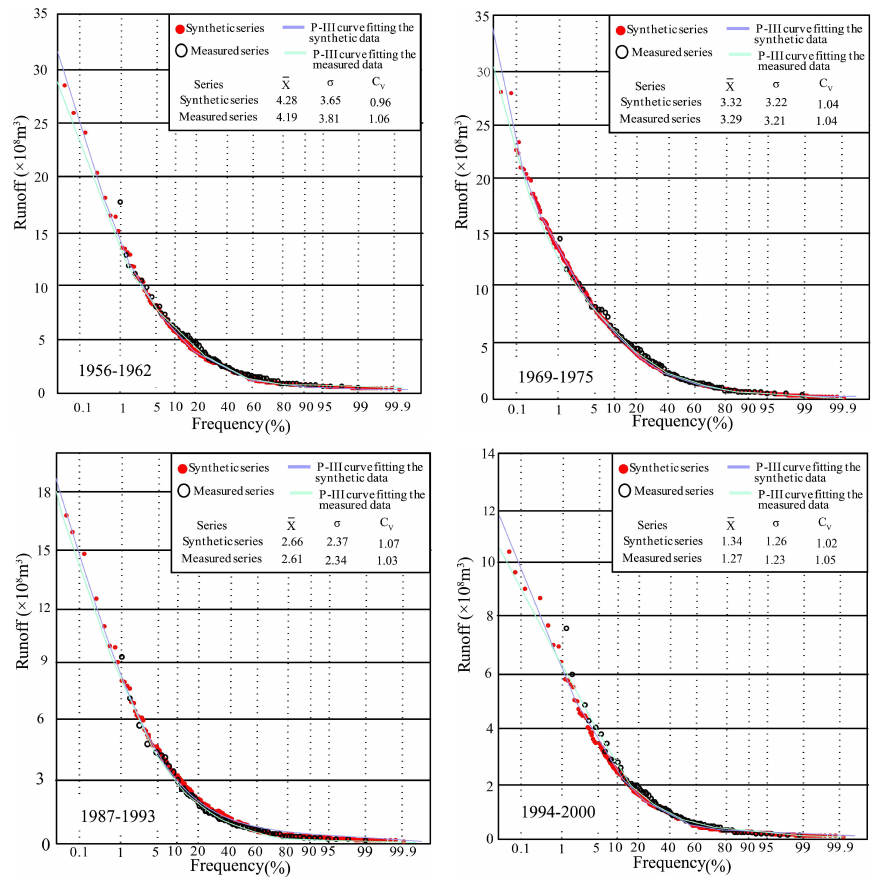
Figure 15. P-III frequency curves fitting segmented synthetic and measured runoff series and statistical parameters at Xianyang gauge.